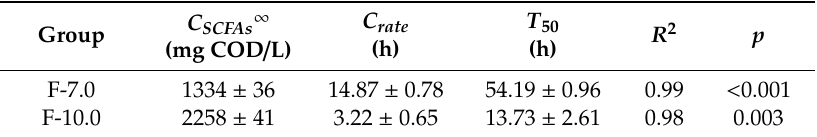
Table 1. Modeling statistics of sigmoid 3 parameter equations for the fitting SCFA-time profiles for the alkali-pretreated FSF.